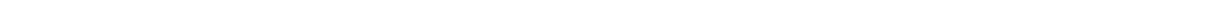
Fig. 3 MarA controls outer membrane barrier function via activation of the mlaFEDCB operon. a ChIP-seq data for MarA and σ 70 binding at mlaFEDCB . Data are smoothed in a 100 bp window. b DNA sequence upstream of mlaF (start codon in blue). DNA elements are labelled and arrows indicate orientation. Transcription start sites identi fi ed in vitro are highlighted by bent arrows. The 5 ′ end of the mlaF 1 and mlaF 2 DNA fragments are indicated by inverted black triangles. c Electrophoretic mobility shift assays with the mlaF 1 fragment (+marbox) and the mlaF 2 fragment ( − marbox). Concentrations of MarA are 0.3, 1.0 and 1.7 μ M. d DNAseI footprinting experiment, using the mlaF 1 DNA fragment, calibrated with a Maxam – Gilbert GA sequencing ladder. Positions relative to the xseA transcription start site (+1) are labelled. Concentrations of MarA are 0.3, 1.0, 1.7, 2.4 and 3.3 μ M. e Results of in vitro transcription assays with the mlaF 1 DNA fragment cloned in plasmid pSR. The gel is calibrated with a GA sequencing ladder. The RNAI transcript, derived from the pSR replication origin, acts as an internal control. Concentrations of MarA are 0.3 or 1.0 μ M. f β -galactosidase assay with lysates of JCB387 transformed with a reporter plasmid where lacZ is controlled by either mlaF 1 (+marbox) or mlaF 2 ( − marbox). Error bars show standard deviation ( n = 3). g The graph shows OD 650 values for cultures of strain BW25113 mlaE ::kan grown with or without 1.0 μ g/ml doxycycline. The BW25113 mlaE ::kan cells were transformed with pBR322 derivatives encoding mlaFEDCB under the control of either the mlaF 1 fragment (+marbox) or the mlaF 2 fragment ( − marbox). Error bars show standard deviation ( n = 3). h , i Accumulation of doxycycline or ef fl ux of ethidium bromide as a function of time for BW25113 (solid line) or the mlaE ::kan derivative (dashed line). j Percentage absorbance of the aqueous phase at equilibrium after mixing with p-xylene. Data are for BW25113 (solid line) and the mlaE ::kan derivative (dashed line). k The graph shows crystal violet adsorption by BW25113 (solid bar) or the mlaE ::kan derivative (open bar). Data are normalised relative to BW25113 cells. Error bars show standard deviation ( n =